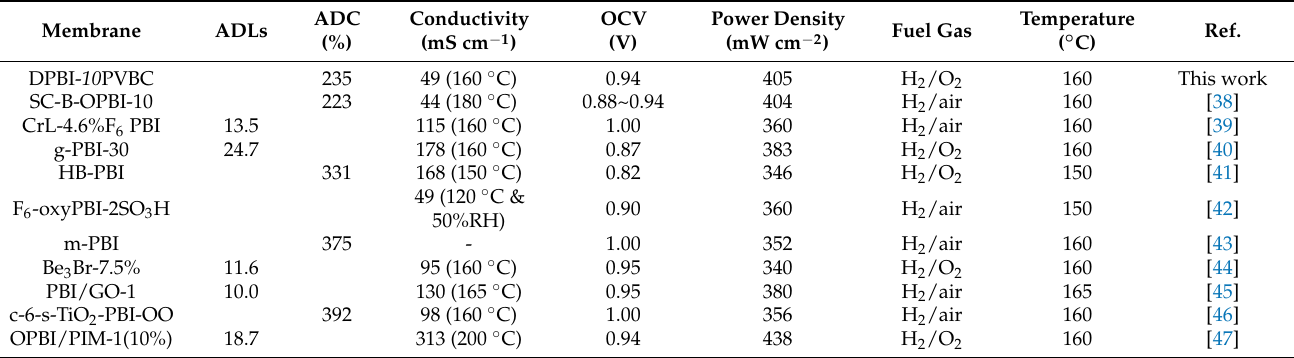
Table 3. Summary comparison of HT-PEMFCs with PA doped PBI based